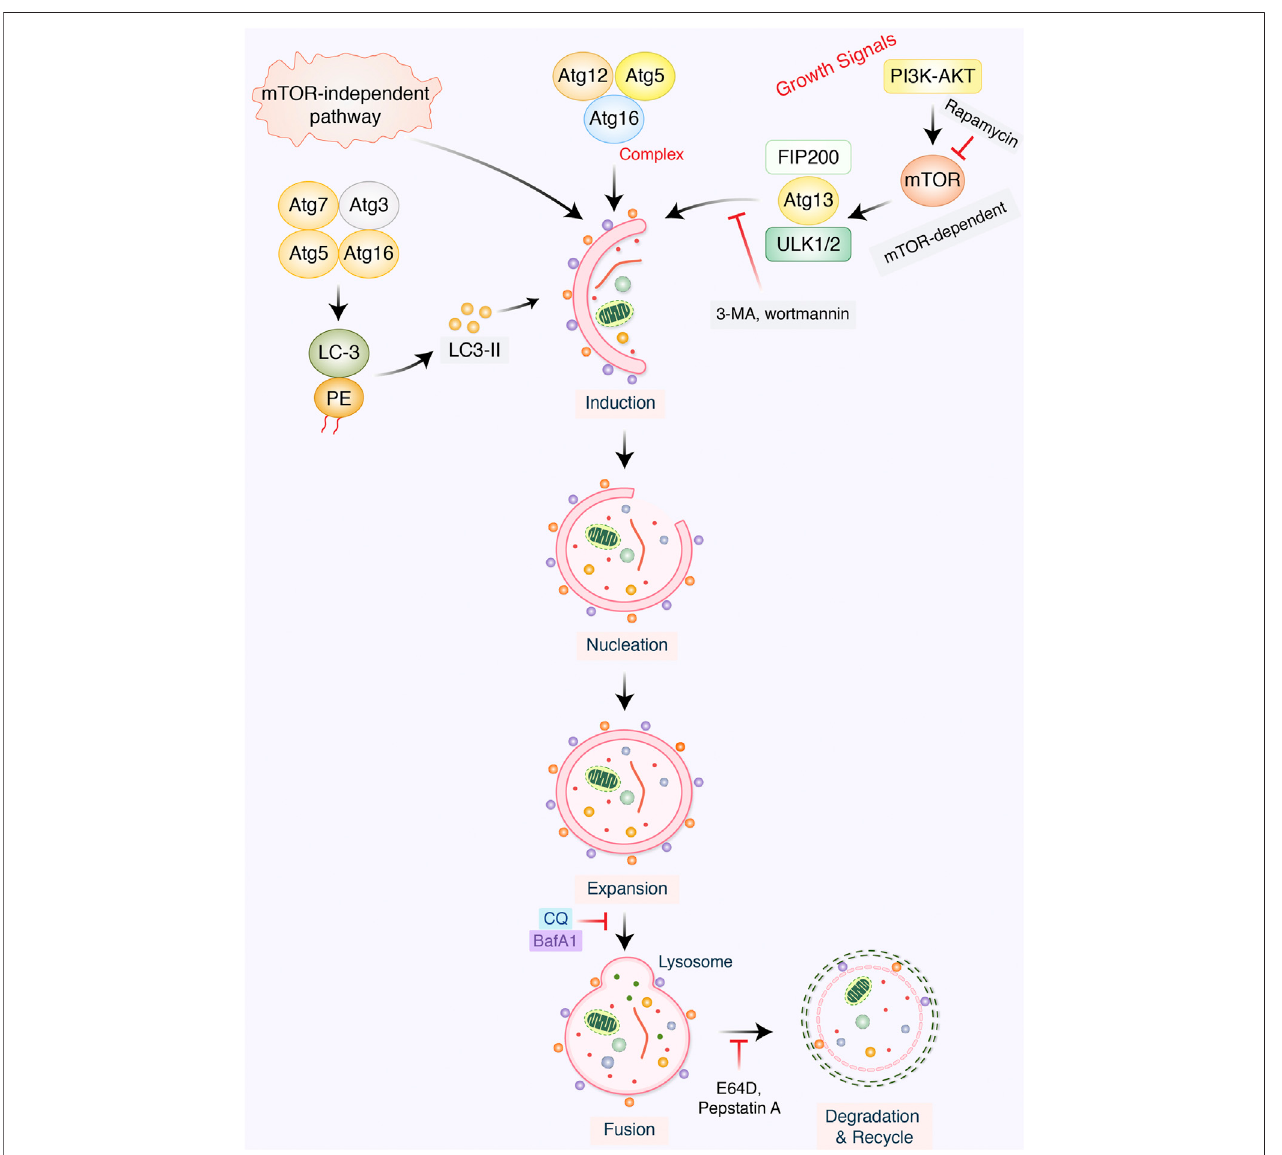
FIGURE1| Mechanismoftheautophagicpathway.Autophagyinitiates via theformationofamacromolecularassemblystructure.PI3K-AKTandmTORcontribute to the formation of the phagophore assembly site (PAS). ULK1/2, ATG-13, Vps34, and beclin-1 complex activate phagophore formation, which creates nucleation elongation as a result of autophagosome formation. Mature autophagosome and lysosome bind to form autolysosome formation. Eventually, autolysosomes are degraded via acid hydrolases, thereby releasing nutrients as well as recycling metabolites.